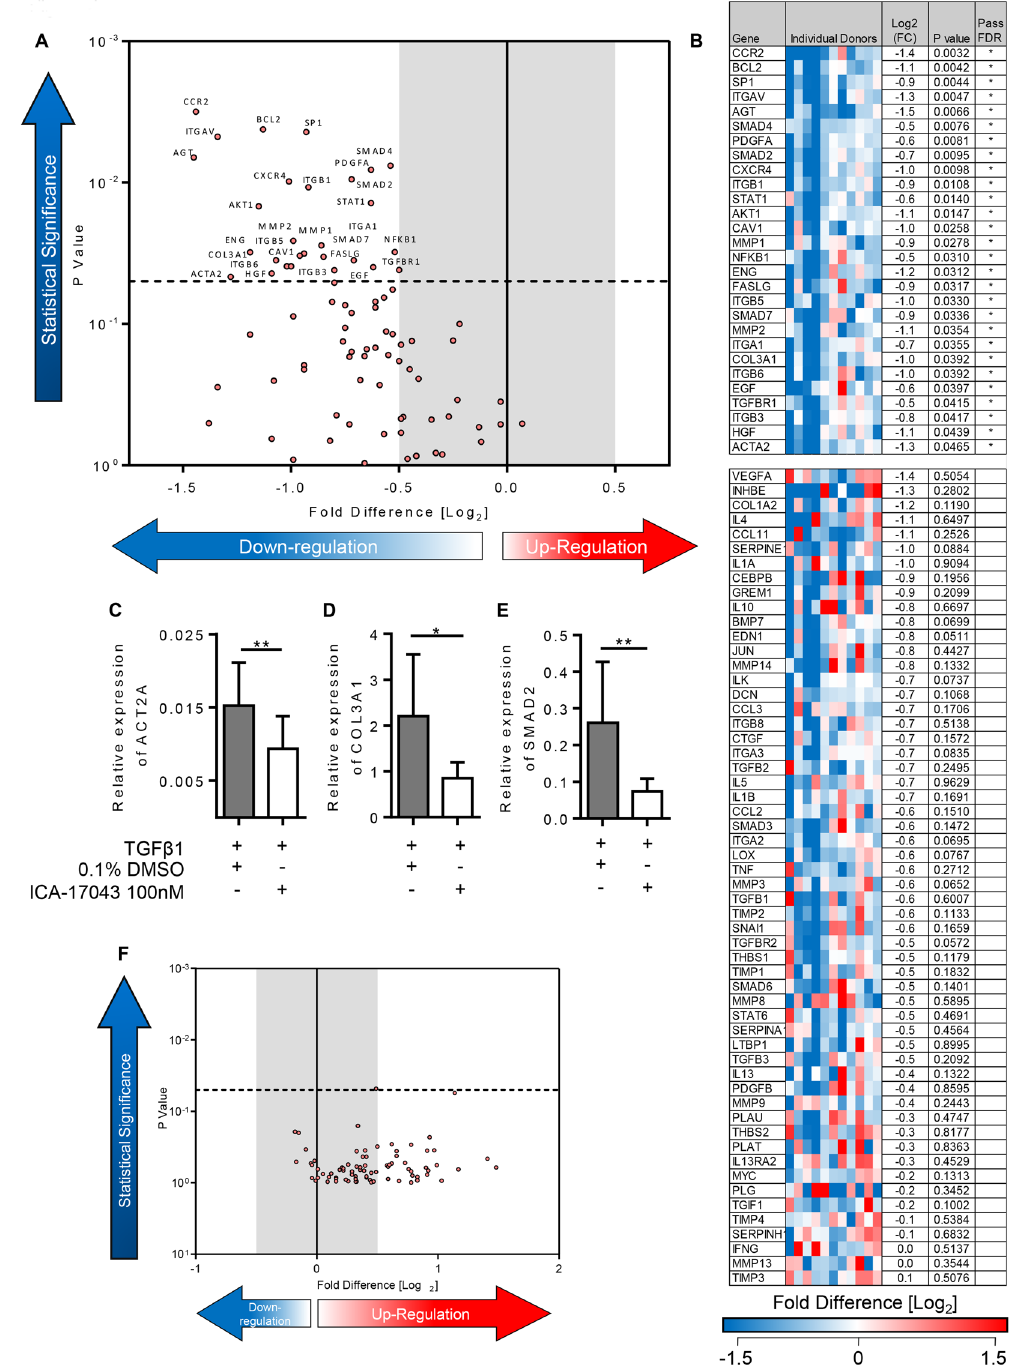
Figure 4. K Ca 3.1 modulation of TGF β 1-induced fibrotic gene expression in an ex vivo model of fibrogenesis. ( A) Volcano plot demonstrating that out of 84 genes, 28 were significantly downregulated following treatment with Senicapoc for 7 days in comparison to TGF β 1-stimulation alone. A 5% false discovery analysis with John D. Storey adjusted p value < 0.05 and absolute value of log 2 (FC) greater than 0.5 was used, depicted by the dotted lines and grey shaded area (results are mean of 11 individual donors). ( B) The individual fold regulation of 84 genes is depicted in this heatmap, highlighting the magnitude of genes downregulated following treatment with senicapoc (100 nM) for 7 days. ( C – E ) Relative expression of ACT2A, COL3A1 and SMAD2 were significantly downregulated when treated with senicapoc, P = 0.0098, P = 0.0210, and P = 0.0078 respectively, consistent with RT 2 profiling gene array results, n = 11. ( F ) No differences between TGF β 1 and TGF β 1 + 0.1% DMSO (vehicle control) were found using RT 2 profiling gene arrays as displayed in the volcano plot identifying the gene expression of 84 fibrosis-associated genes. Results are presented as mean ± SEM, *** P < 0.01, * P <